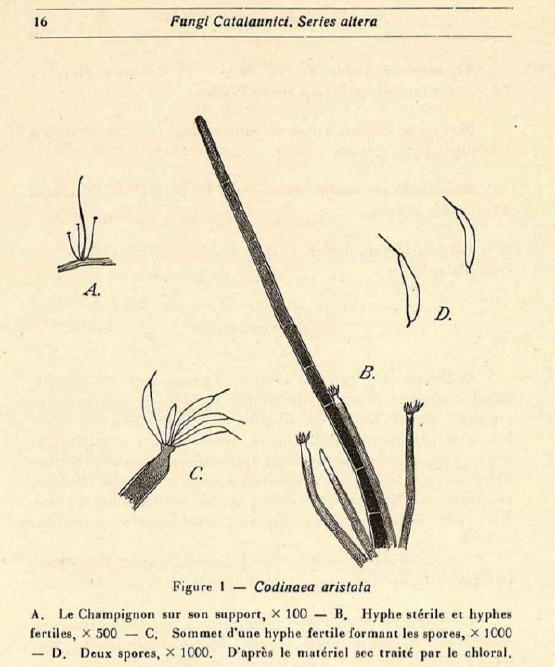
Figure 1. Illustration of a seta, conidiophores, and conidia of Codinaea aristata (holotype, Maire